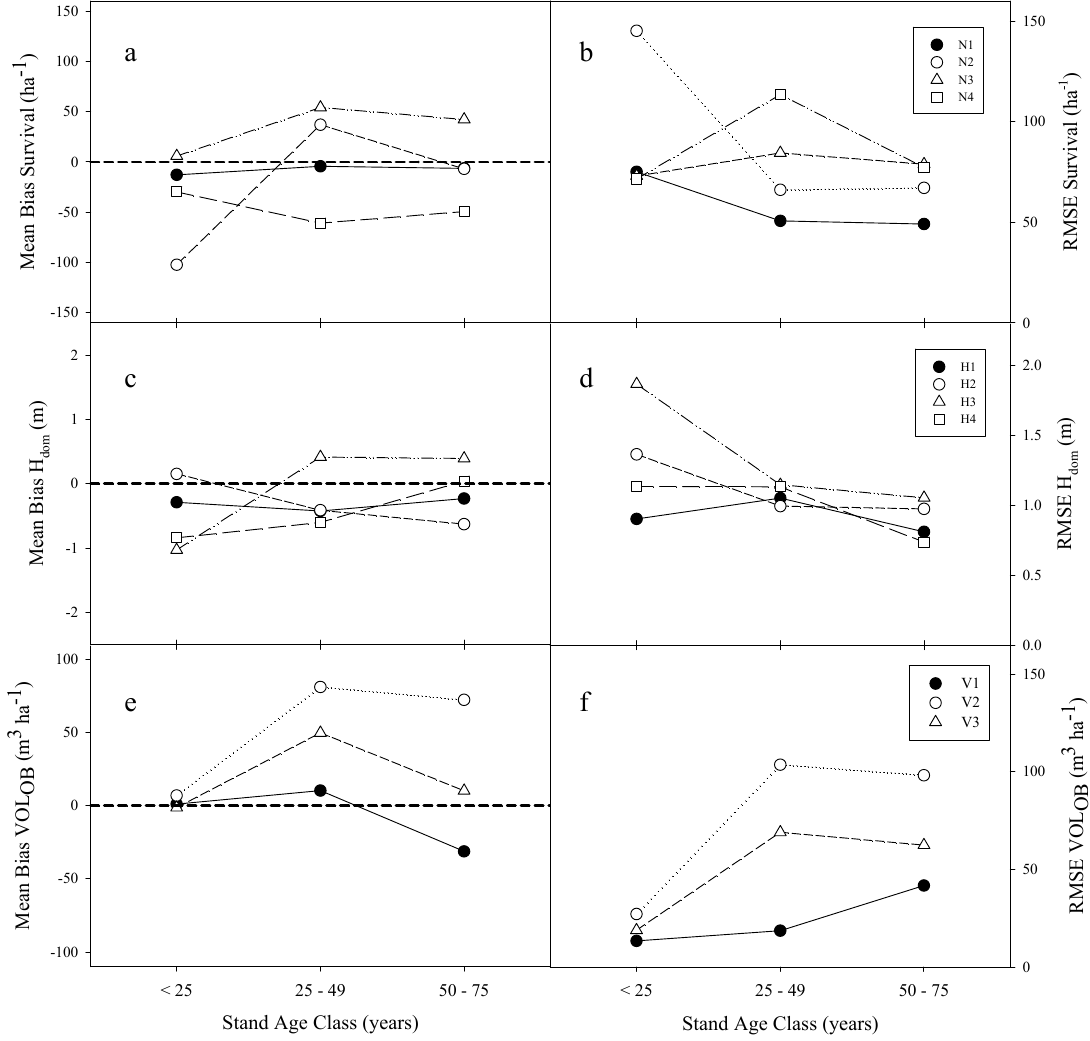
Figure 4. Mean bias and RMSE of the models presented in this study and reported in literature to predict survival ( a , b ), H ( c , d ) and VOL ( e , f ) of longleaf pine dom OB plantations across four stand age classes: <25, 25–49 and 50–75 yrs. The survival models are: current report (N1), Brooks and Jack [7] (N2), Lohrey and Bailey [5] (N3), and Lauer models are: current report (H1), Brooks and Jack [7] (H2), and Kush [34] (N4). The H dom Farrar [4] using SI and base age 25 yrs. (H3) and using SI and base age 50 yrs. (H4). The VOL models are: current report (V1), Brooks and Jack [7] (V2) and Lohrey and OB Bailey [5] (V3).